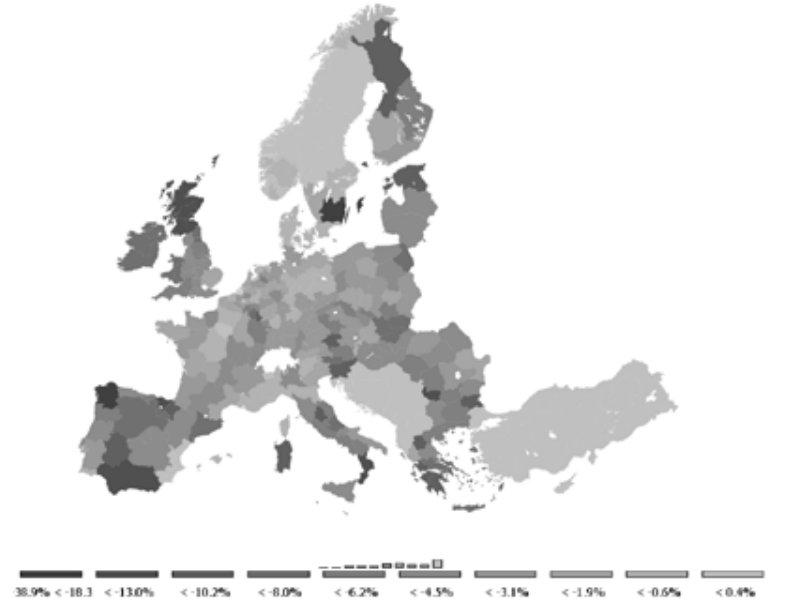
Figure 3. Regional land use change (percentage change relative to baseline).